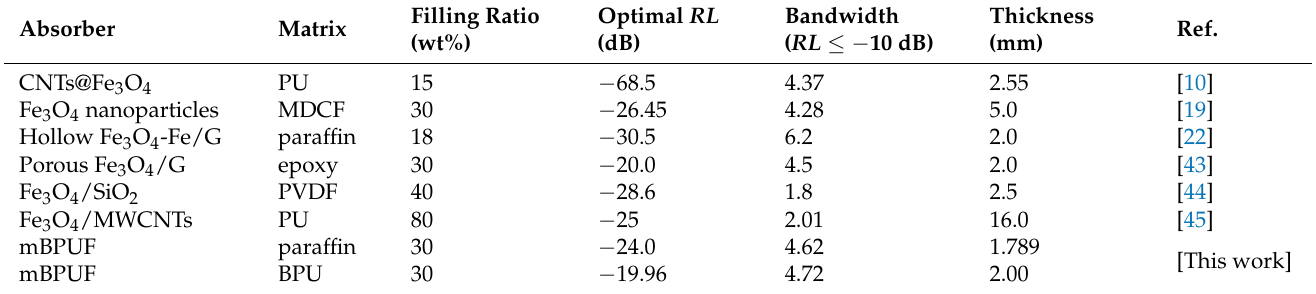
Table 1. The microwave absorption effects of some previously reported Fe 3 O 4 foamed